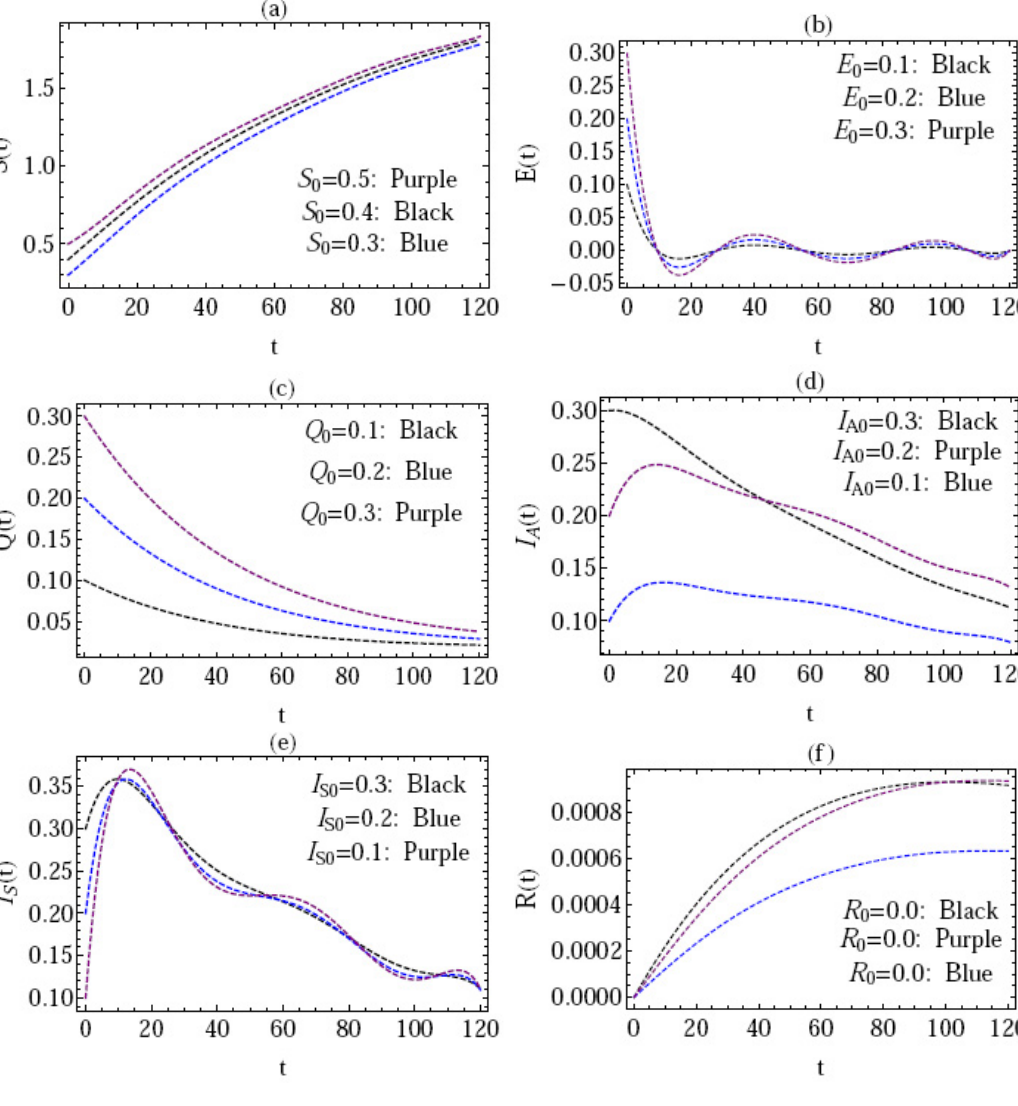
Figure 4. Behavior of the approximate solution via different values of initial values. ( a – f ) S ( t ) , E ( t ) , Q ( t ) , IA ( t ) , IS ( t ) , R ( t ) . Table 1. The CPU running times for the present method and the GRK4